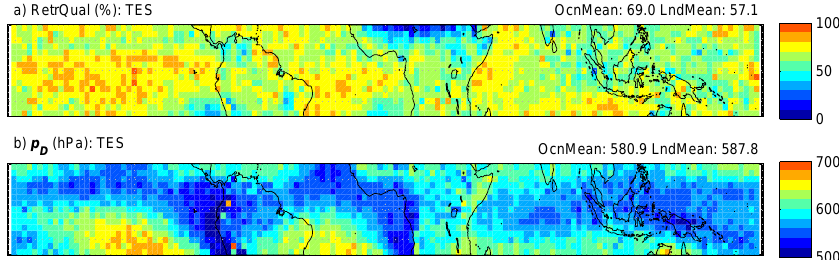
Fig. 3. (a) TES HDO retrieval quality and (b) mean p D (height of peak HDO sensitivity) over 825 to 510hPa for high quality retrievals only. Both fields are the mean across all retrievals from 2006–2009. Table 1. Pattern correlation between TES HDO retrieval quality (Fig. 3a) and p D (height of peak HDO averaging kernel sensitivity) (Fig. 3b) and candidate variables. Cloud fraction is the frequency of occurrence within a grid cell of observations with τ greater than 0.3. For p D , correlations are for high-quality observations only. The strongest correlation in for each column is shown in bold. Retrieval quality Pressure of peak HDO sensitivity ( p D ) Description Variable Ocean Land Ocean Cloud optical